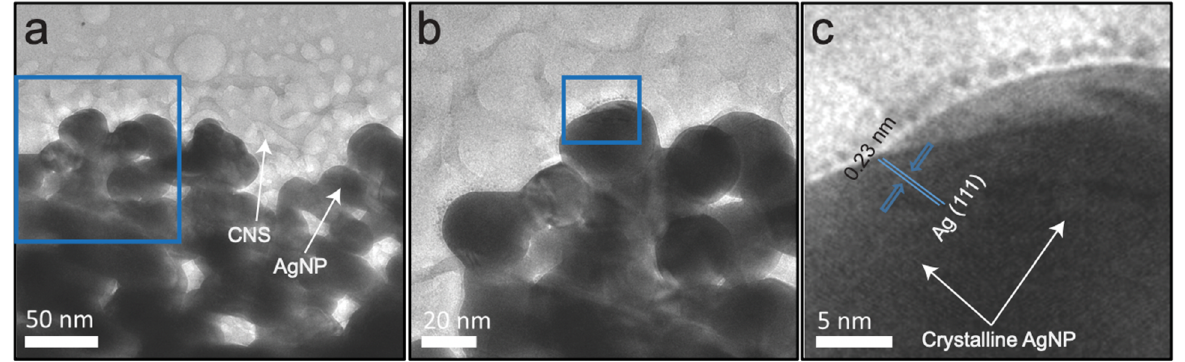
Figure 6. TEM images of the AgNP–CNS nanocomposite: ( a ) low-resolution TEM image, ( b ) high- resolution TEM image corresponding to the rectangular area in ( a ), and ( c ) a higher-resolution TEM image corresponding to the rectangular area in ( b ).